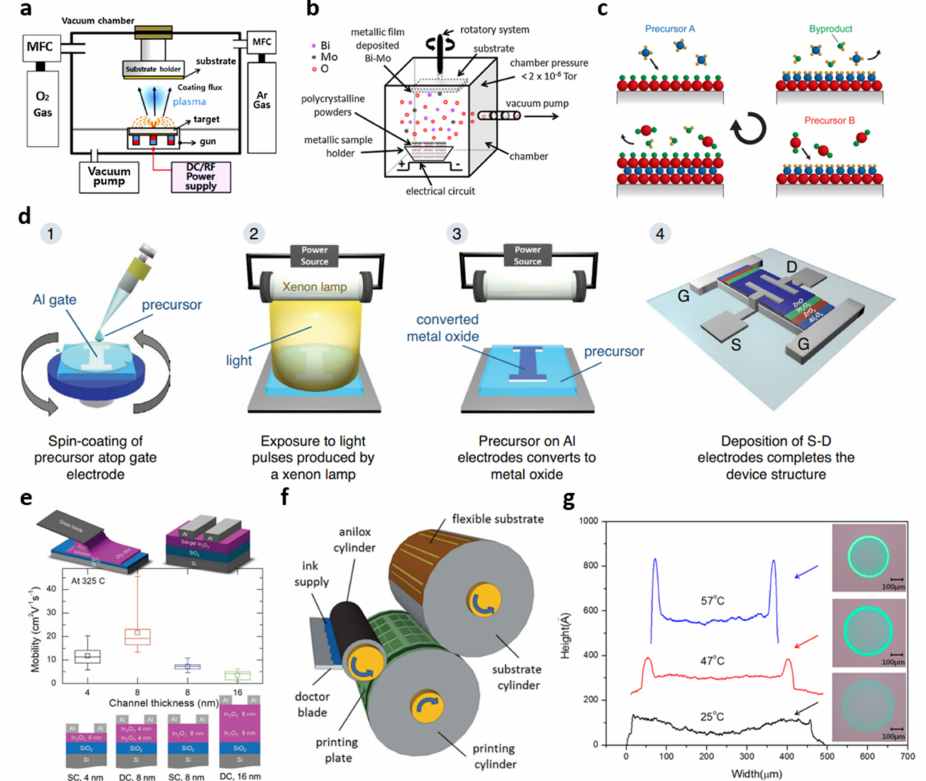
Figure 1. ( a ) Schematic of RF sputtering (adapted from [22] with permission from the Elsevier B.V.); ( b ) Schematic of thermal evaporation (adapted from [23] with permission from the Elsevier B.V.); ( c ) Schematic of ALD cycle (adapted from [24] with permission from the American Chemical Society); ( d ) Spin coating process of metaloxide TFTs via photonic curing (adapted from [25] with permission from the John Wiley and Sons); ( e ) Schematics of blade-coating setup and comparison of mobility according to channel layer thickness and number of layers (adapted from [26] with permission from the John Wiley and Sons); ( f ) Schematic image of the flexographic printing process (adapted from [27] with permission from the John Wiley and Sons); ( g ) Surface profiles of inkjet-printed In 2 O 3 single dots at substrate temperatures of 25, 47, 57 ◦ C (adapted from [28] with permission from the American Chemical